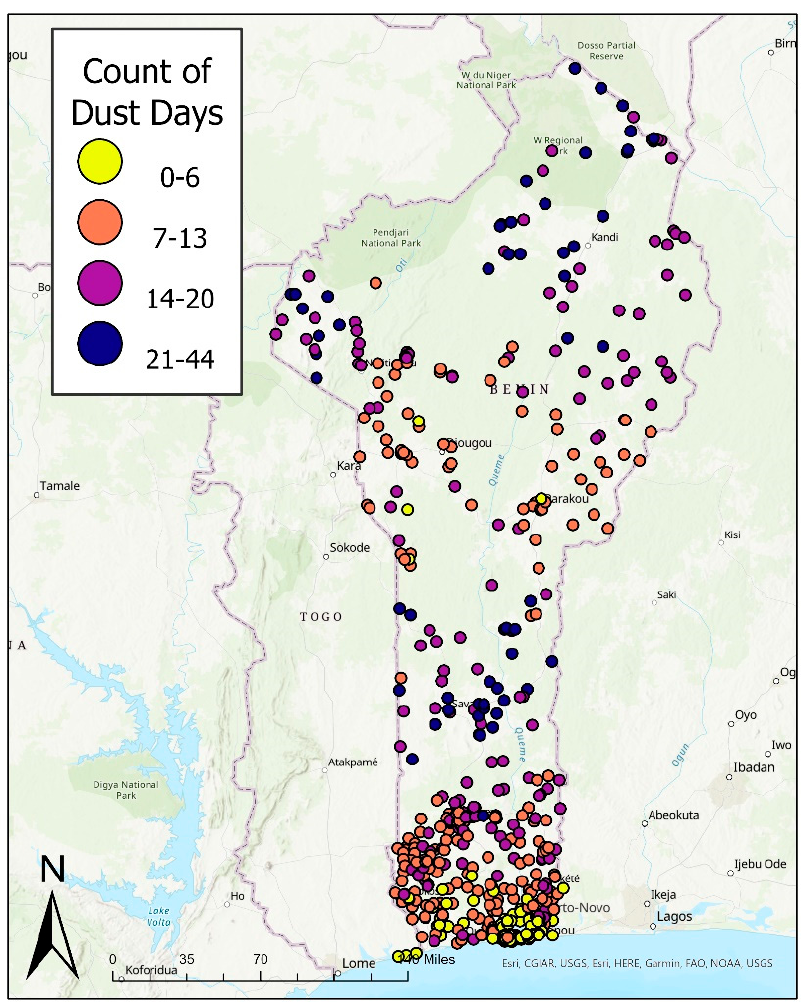
Figure 2. Total number of exposed days to dust per PSU in Benin from 23 November 2017 to 4 February 2018.